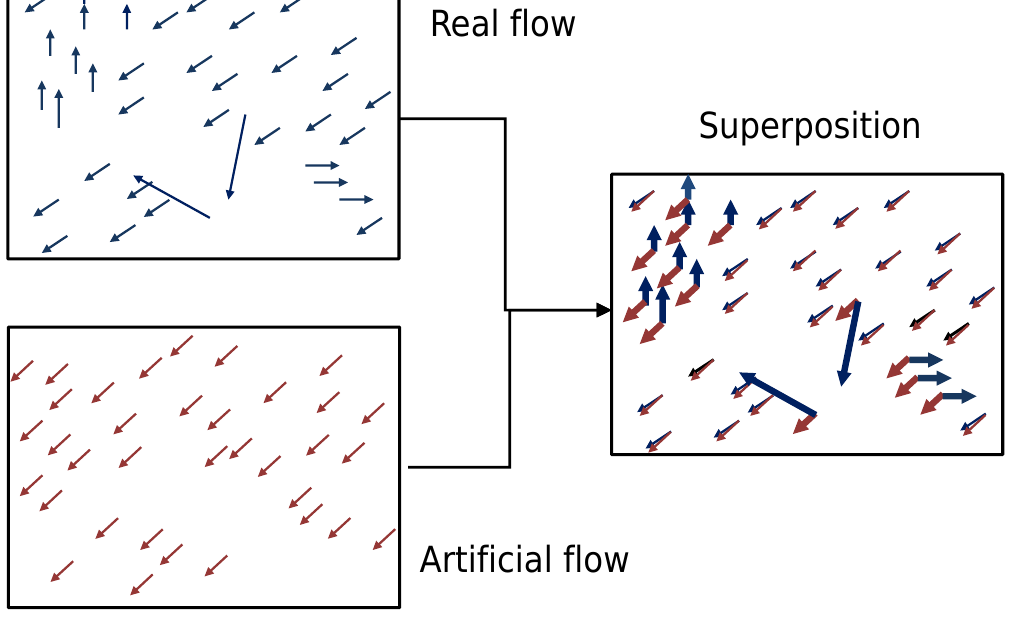
Figure 4. Illustrative representation of a real optical flow, an artificial optical flow and the superposition of these two flows. In the last image pixels are highlighted where the discrepancies between the flows surpass some thresholds defined by mathematical rules explained in the